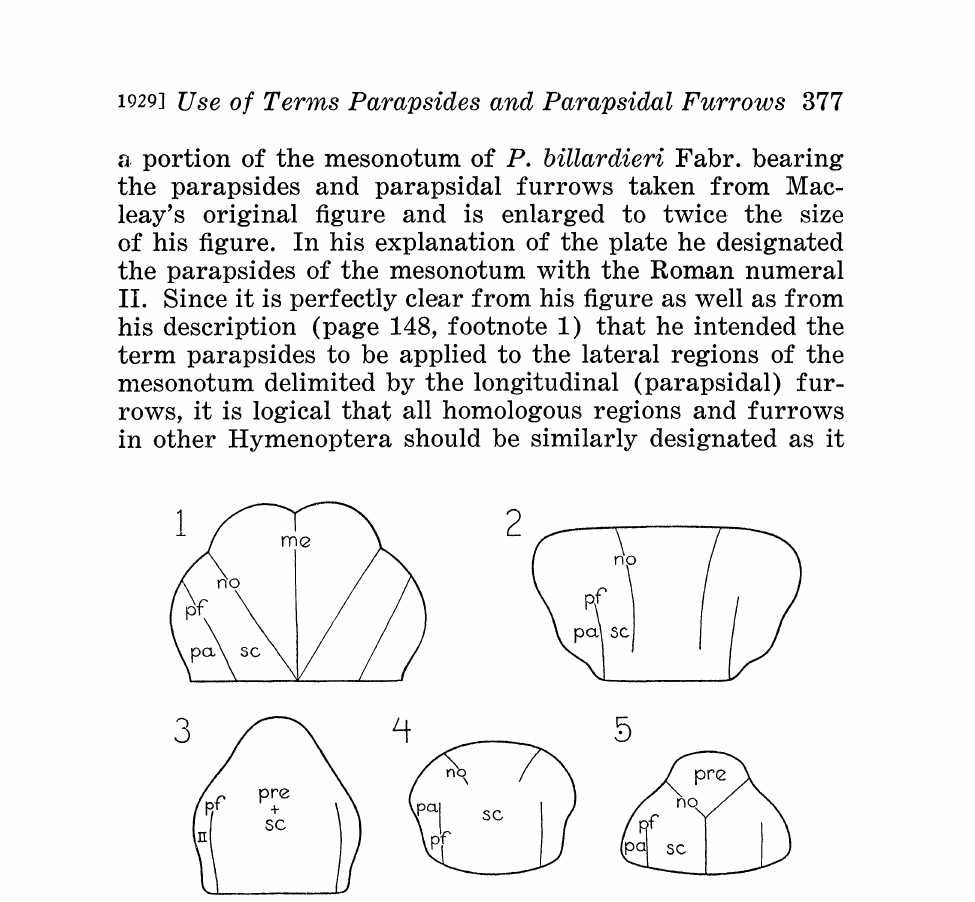
Fig. 1. Portion of the mesonotum of Xiphydria. Fig. 2. Portion of the mesonotum of Ampulex. Fig. 3. Portion of the mesonotum of Polites billardieri Fabr. Fig. 4. Portion of the mesonotum of Myopopone castanea maculata Roger. Fig. 5. Portion of the mesonotum of Paraponera clavata F.